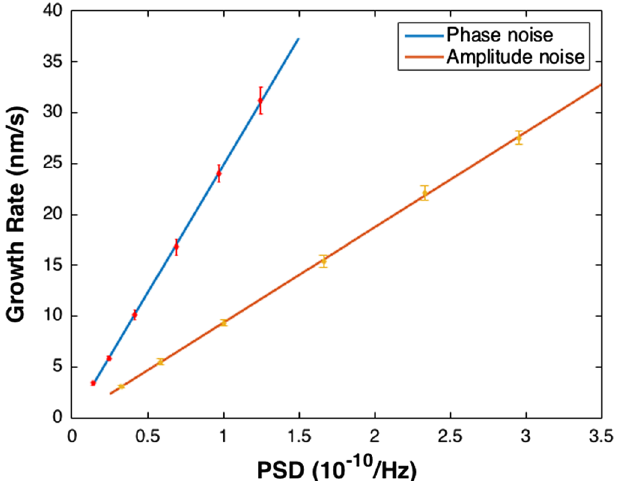
FIG. 16. Growth rate dependence on bunch length C Δ ϕ ð σ ϕ Þ , phase